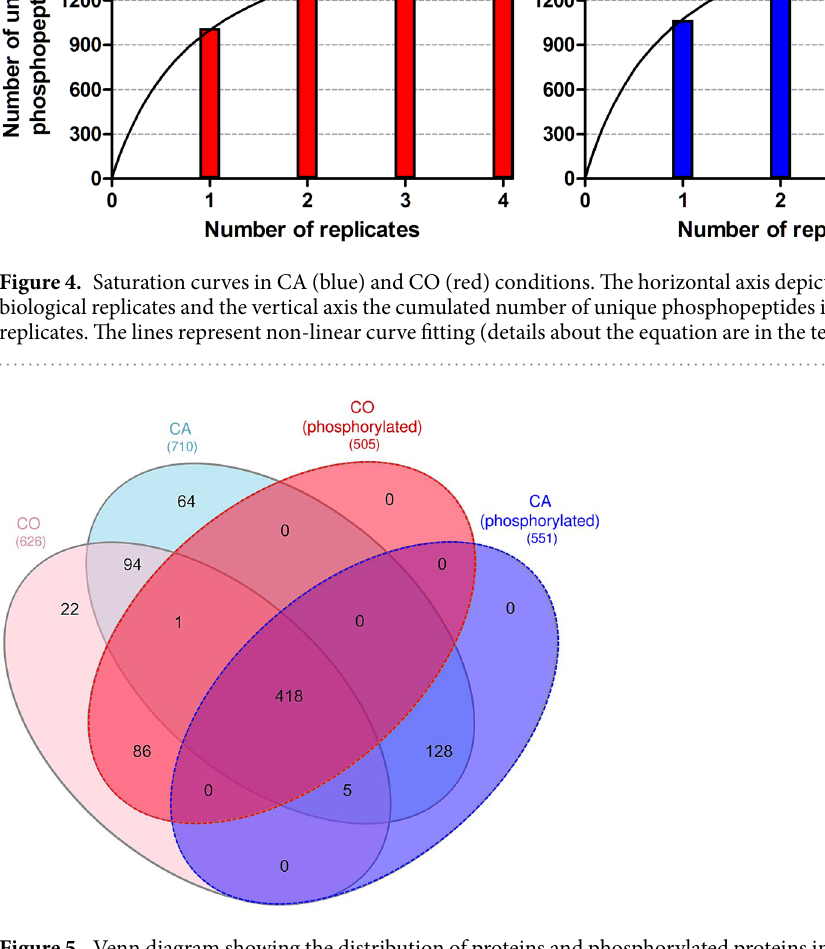
Figure 5. Venn diagram showing the distribution of proteins and phosphorylated proteins in CA (blue) and CO (red) conditions. Numbers in brackets indicate the number of entries in each